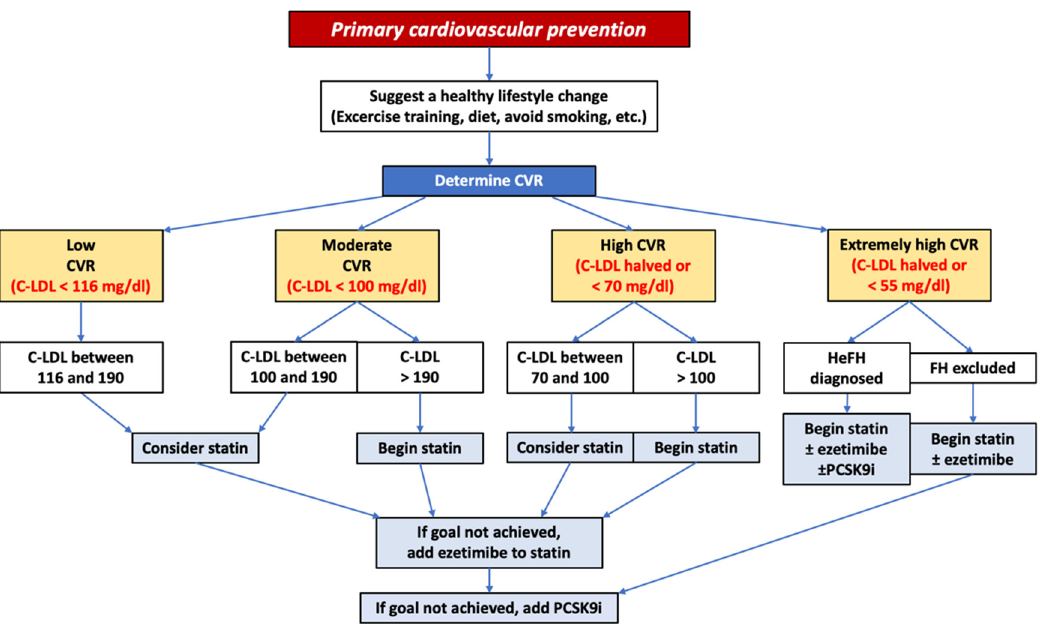
Figure 1. Flowchart of interventions for primary cardiovascular prevention according to the European Society of Cardiology guidelines. CVR: cardiovascular risk, C-LDL: LDL cholesterol, FH: familiar hypercholesterolemia.